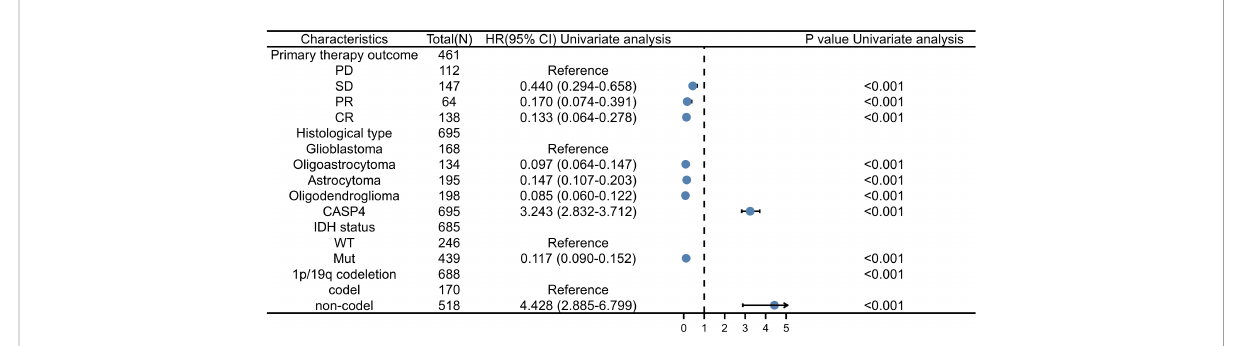
FIGURE 4 Forest plot for the hazard ratios of CASP4 expression. Association between CASP4 expression and clinical pathological factors based on univariate Cox regression analysis.